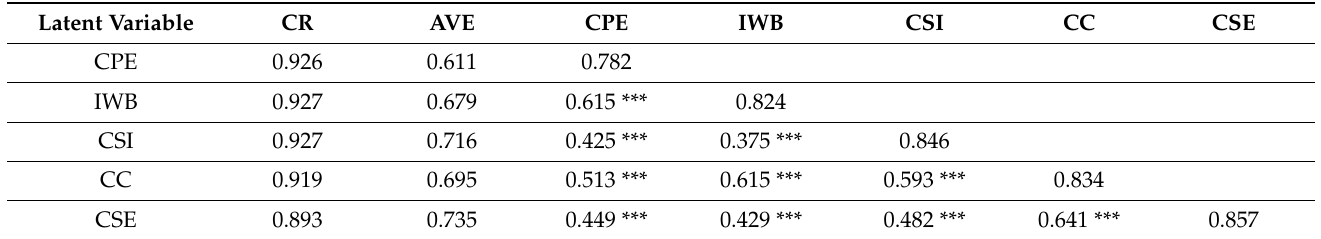
Table 3. Reliability and validity estimates.